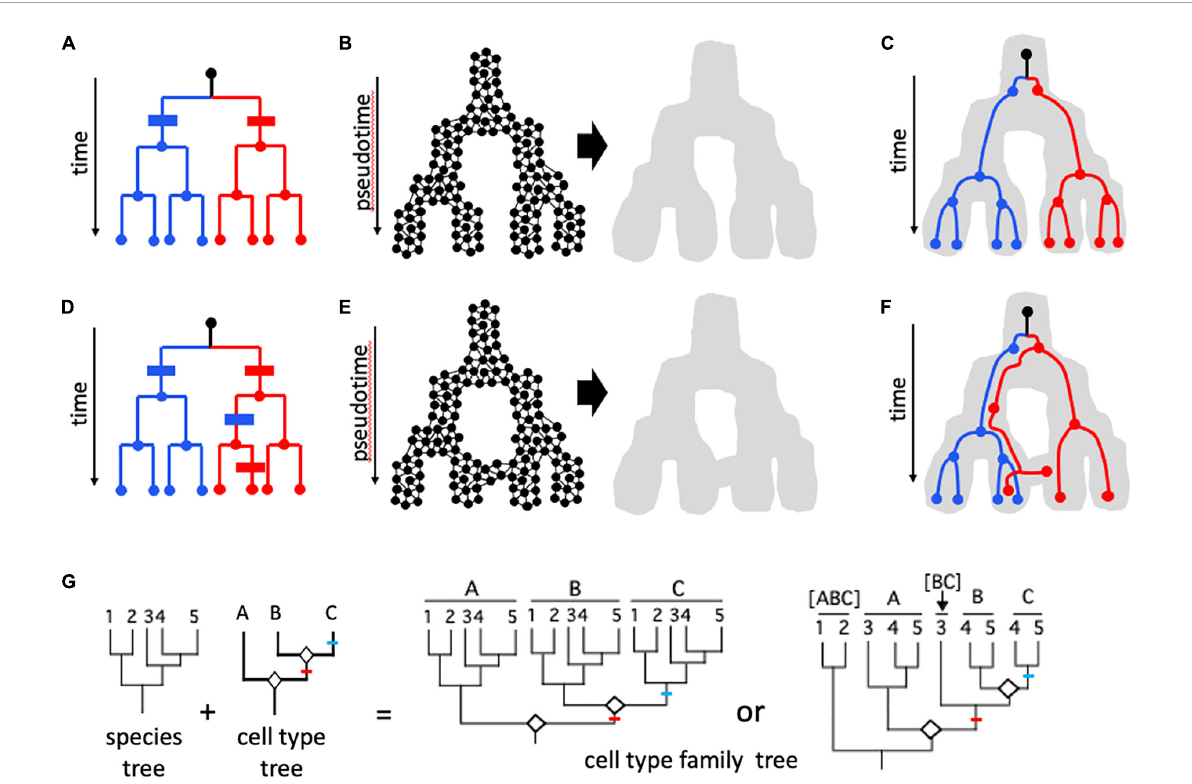
FIGURE4 Cell lineages. (A–F) Cell mitotic lineages vs. transcriptomic manifolds (Wagner and Klein, 2020). (A,D) Tree-like relationships describing clonal cell lineages progressing in real time from a founder cell (black dot at top of dendrogram) to eight cells in red and blue sub-lineages through a series of mitotic cell divisions. (B,E) Construction of state manifolds from single cell transcriptomic data. This involves aggregating cells with similar transcriptomic positioning in high-dimensional parameter space (e.g., a UMAP projection) to produce a landscape/manifold (gray shape) which reflects gene expression dynamics in pseudotime. Manifolds can be non-reticulate (acyclic) and tree-like as in (B) , or can form reticulate (cyclic) networks as in (E) . In (C,F) , cell mitotic lineages from (A,D) , respectively, are shown included within the developmental manifold. In (C) , there is congruence between the topologies of the lineage and the manifold: transcriptomic signatures are perfectly correlated with cell lineage, and this can be shown in panel (A) as two synapomorphies (blue and red bars) with no homoplasy (additional change in parallel). In contrast, in (F) there is incongruence between cell lineage and transcriptome; with information from cells at intermediate developmental stages it is possible to see that the incongruence is due to two events: an early shift from the right-hand branch represented by most “red” cells to the left-hand (blue) branch of the manifold, and a later shift of some but not all cells of this lineage back to the red fate. This is shown in (D) with two additional changes (apomorphies)—a blue change (parallelism) in the red lineage followed later by a reversion to the red state for one of the two cells. These two additional steps represent homoplasy in the mapping of gene expression characters on the mitotic lineage tree. (G) The evolution of homologous cell types, following concepts of Arendt et al. (2016, 2019). A phylogeny of five species (1–5) is shown, along with a tree relating three cell types (A–C) formed by “cell typogenesis” (white diamonds at nodes). Together, speciation and cell typogenesis produce a cell type family tree (analogous to speciation and gene duplication producing a multigene family tree). Speciation and cell typogenesis are two independent processes, and so can occur at different times relative to one another. Two scenarios are shown. In the first case, the two origins of new cell types occurred prior to the speciation events that produced the five species; the common ancestor of the five species therefore possessed all three cell types, and therefore all five species possess cell types A, B, and C; A 1 − 5 , B 1 − 5 , and C 1 − 5 are analogous to orthologous genes. In the second scenario, cell typogenesis events are interspersed with speciation events: the first cell typogenesis event occurs after the ancestor of species 1 and 2 diverged from the ancestor of species 3–5, and the second cell typogenesis event occurs after the divergence of the ancestor of species 3 and the ancestor of species 4–5. Therefore, only species 4 and 5 possess all three cell types. Species 3 possesses cell type A and the progenitor of cell types B and C; species 1 and 2 possess only a single cell type, derived from the progenitor of all three other cell types. The analogous situation in a multigene family would consider [BC] in species 3 to be co-orthologous with B and C, which are